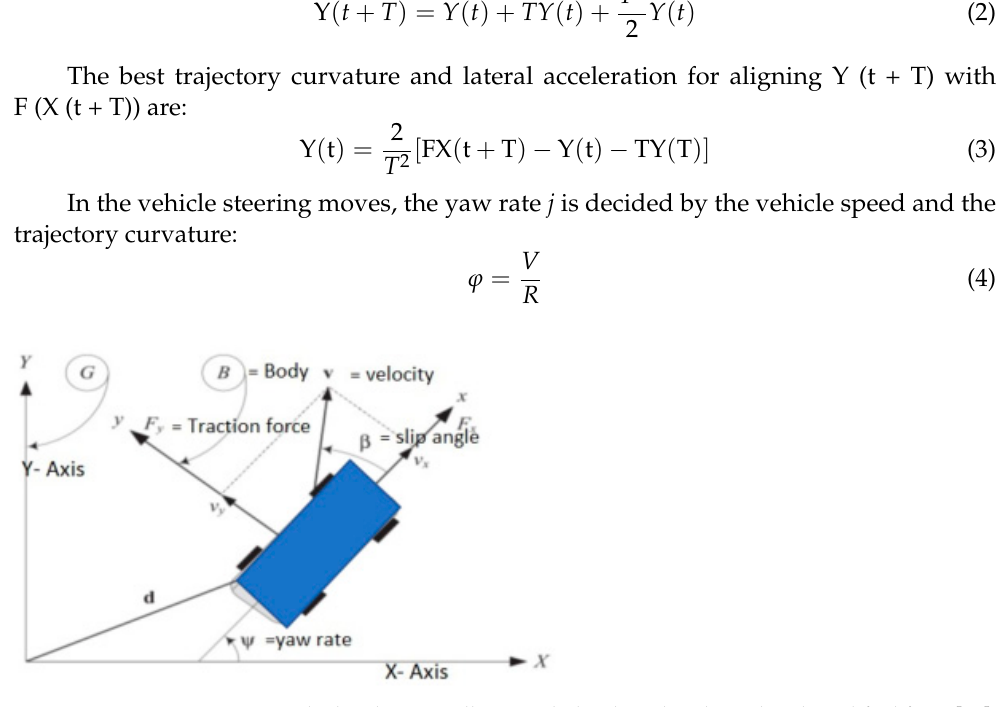
Figure 4. Preview capability of MPC.